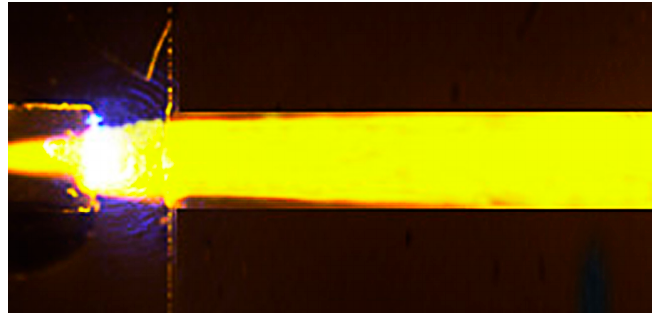
Figure 3. The experimental result of light passing through the collimating unit.